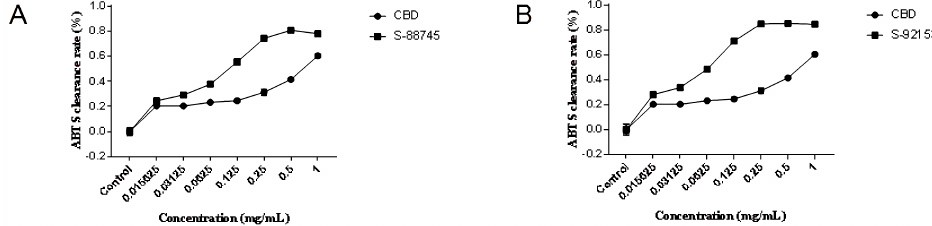
Figure 3. The graph of ABTS scavenging ability. ( A ) The ABTS scavenging abilities of CBD and its skeleton derivative, S-88745. ( B ) The ABTS scavenging ability of CBD and its skeleton derivative, S-92153. The control group was not treated with CBD, S-88745 and S-92153, and only contained ABTS solution. The experiments were repeated three times. Each bar illustrates the average ± standard deviation (SD) counted from three experiments.